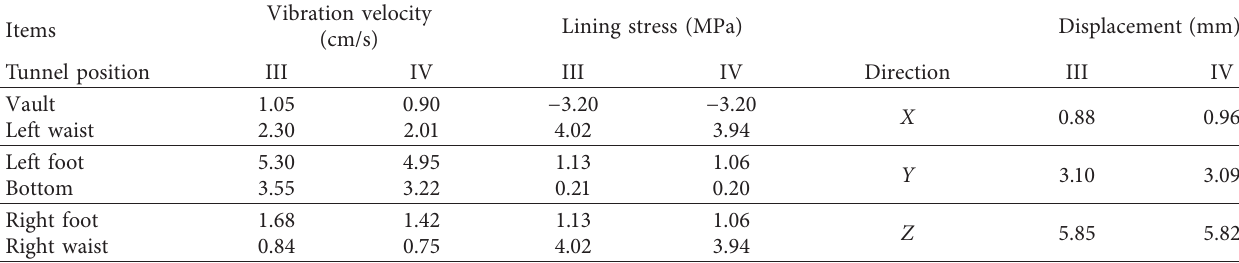
Table 5: The dynamic response of the existing tunnel to blasting under different surrounding rock conditions. Items